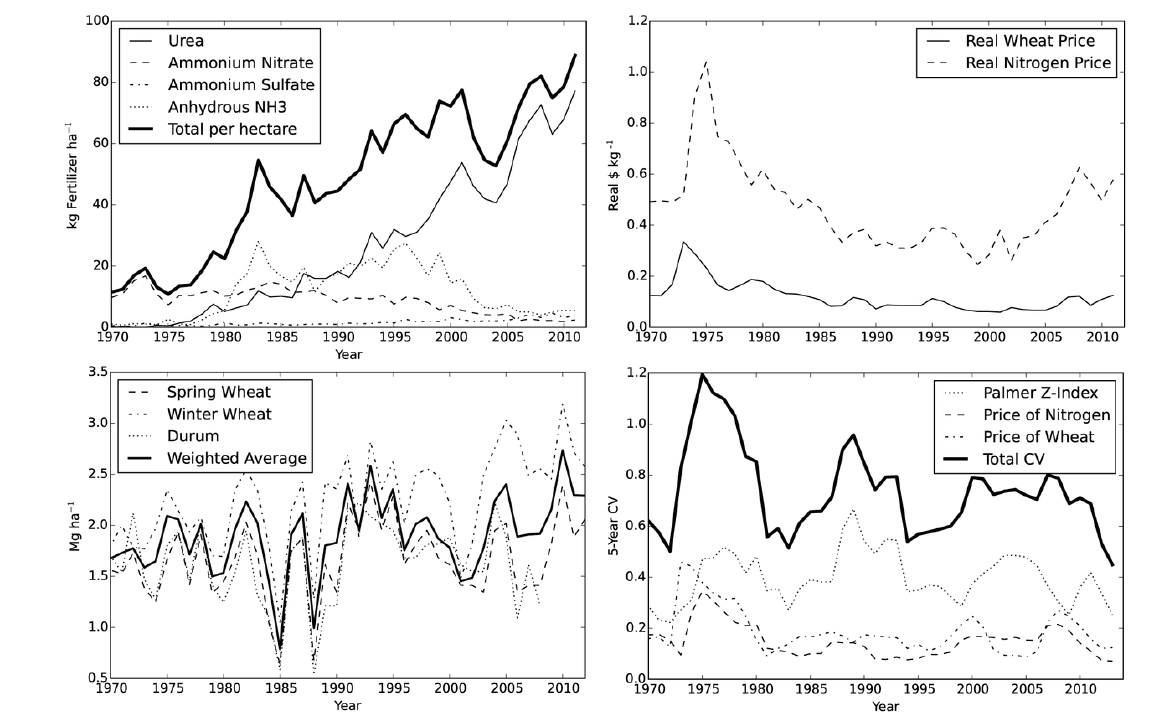
Fig. 2 . Clockwise from upper left: kilograms of fertilizer used on a per-hectare basis in Montana,